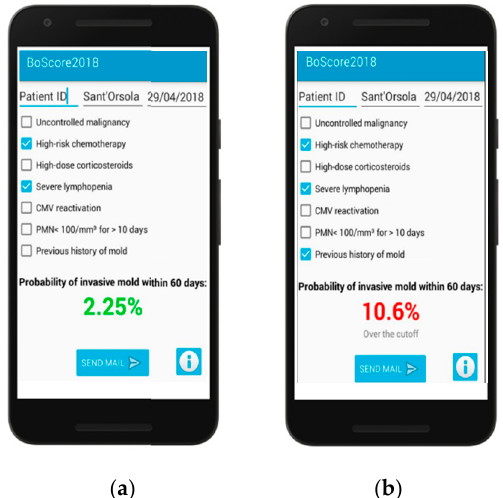
Figure 5. Smartphone-assisted prognostic model assessments of lower-risk ( a ) and higher-risk ( b ) nonneutropenic patient. The probability of IMD within 60 days is estimated using the formula: Risk = (0.68 × uncontrolled malignancy) + (0.79 × high-risk chemotherapy) + (0.80 × high-dose corticosteroids) + (0.89 × severe lymphopenia) + (1.14 × CMV reactivation) + (1.52 × prolonged neutropenia) + (1.64 × previous mold disease) − 5.45. To calculate the 60-day probability from the formula, the calculated result is first converted from log odds to odds (eRisk); then odds must be converted to probability using the formulae: Risk/(1 + Risk).